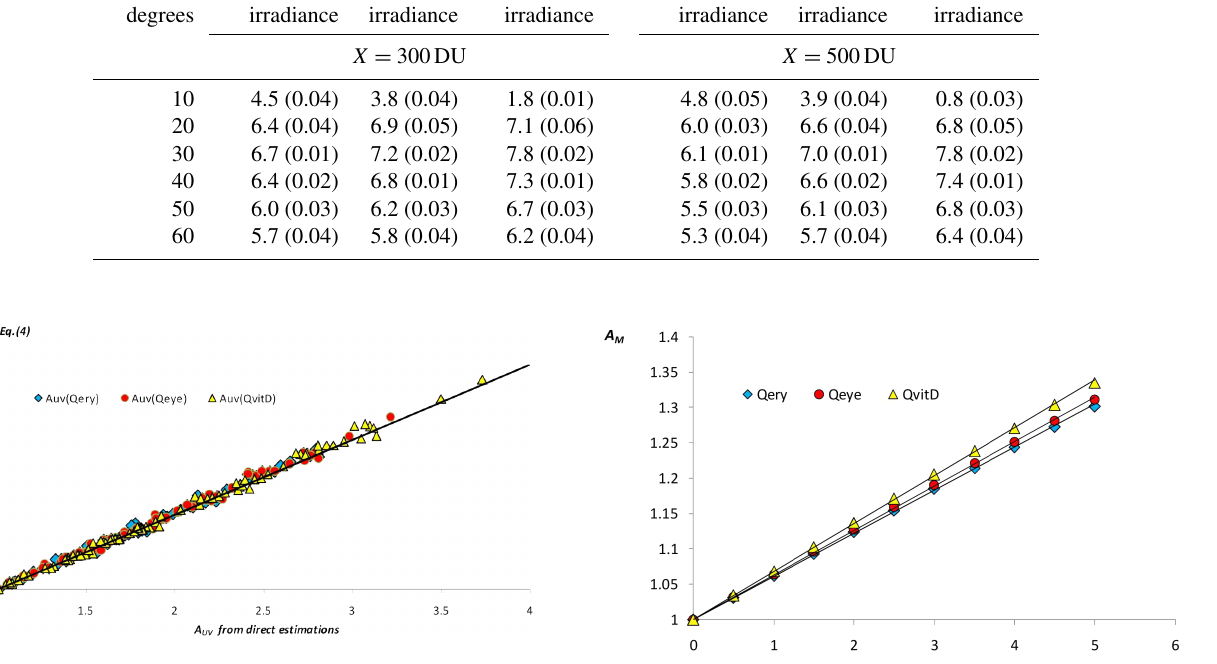
Figure 2. The comparison of A UV amplification factor calculated from Eq. (4) as multiplication of A M A X A AOD A S with the direct model simulation of UV amplification. All the parameters ( A UV , A M A X A AOD A S ) were obtained from accurate model simula- tions. Comment. The simulations were performed for different alti- tudes ( H = 0 and H = 5km), aerosol optical depth (AOD 340 = 0, 0.2, 0.4), single scattering albedo (SSA = 0.88, 0.96), Angstrom ex- ponent ( α = 0 . 6, 1.0, 1.5), total ozone ( X = 250, 300, 350DU), sur- face albedo ( S = 0, S = 0 . 9) and solar elevation ( h = 20 and 50 ◦ ). For estimating the UV amplification we assume at H = 0km the conditions with 350DU, AOD 340 = 0 . 4, S = 0% and normalized the BAUVR at the altitude H = 5km to the value calculated with these parameters.